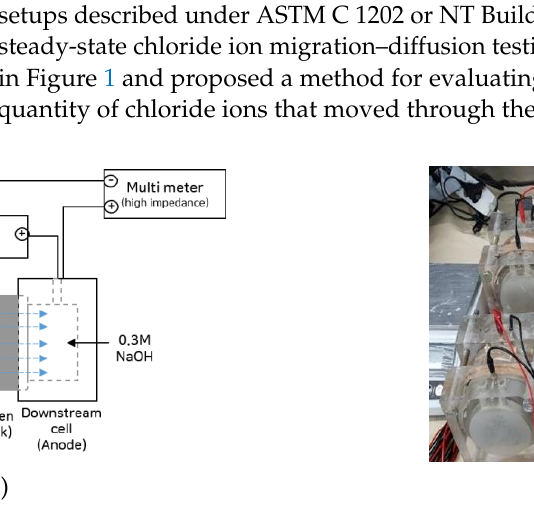
Figure 1. ( a , b ) Test set-up for chloride ion migration–diffusion test (ASTM C 1202).